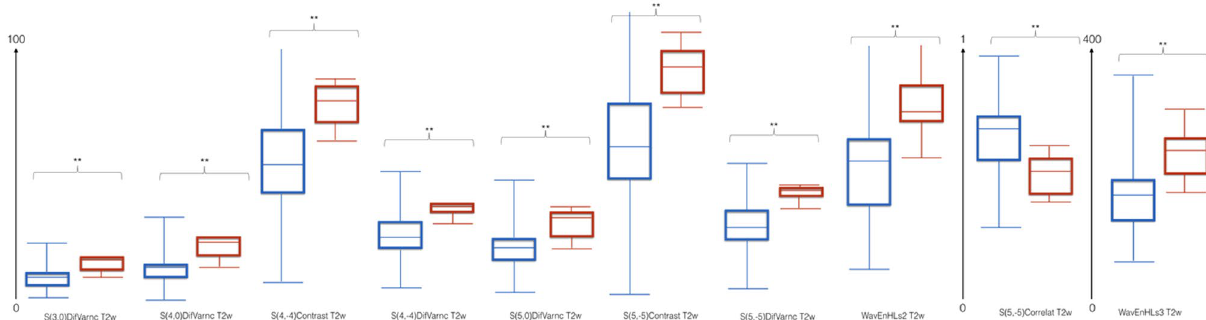
Figure 3. Box-Whisker plots of the ten selected texture analysis features. Dimension reduction yielded 10 TA features carrying prognostic information, which were all based on T2w images. Red: positive 5-year major adverse cardiovascular and cerebral events (MACCE), blue: negative 5-year MACCE. ** = p <